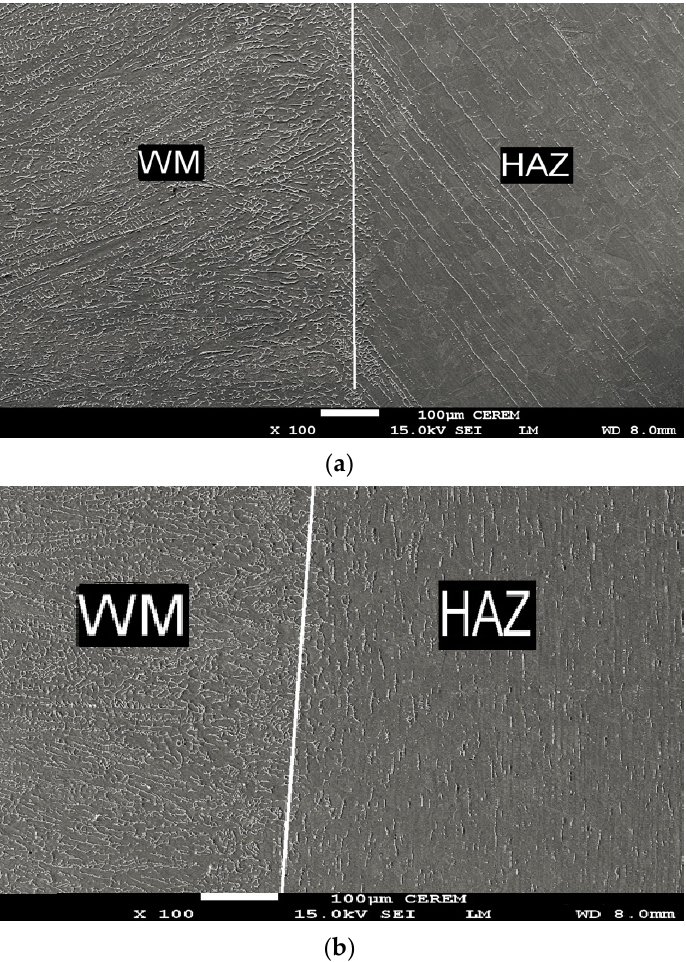
Figure 11. SEM Micrograph in transition zone (WZ/HAZ) in ATIG weld ( a ) and TIG weld ( b ) (100×). Figure 12a,b represent the measurements of ferrite volume proportions in the aus- tenite matrix. The advisable proper amount of δ -ferrite in austenitic stainless steel welds is less than 10% volume to ensure a better ductility, toughness, and corrosion resistance, and no less than 5% to avoid solidification cracking [32]. The results reported in Table 11 show the measurements taken in seven different lo- cations in the weld zone and the mean value of ferrite volume. The proportions are up to 5.56% in the conventional TIG process and 8.63% for ATIG weld. Table 11. Ferrite volume fraction measurement. Sample